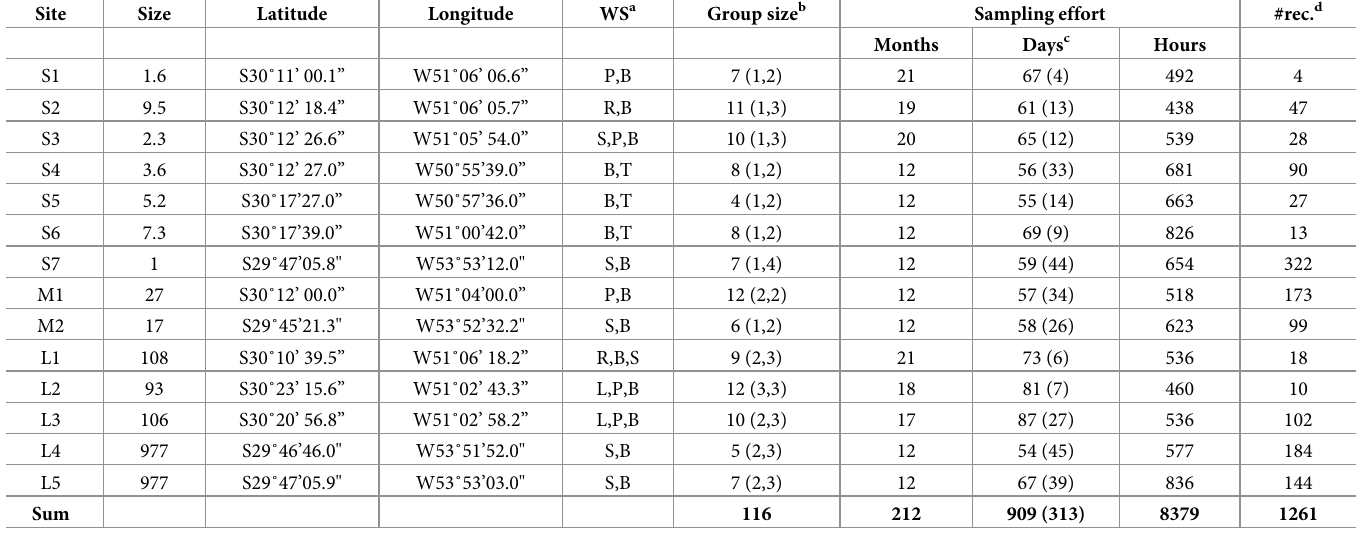
Table 1. Study fragments, brown howler group size, sampling effort, and number of drinking records.